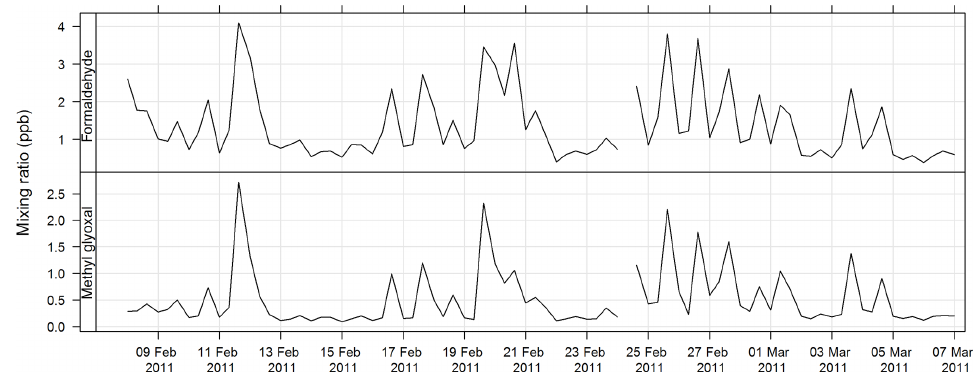
Figure 19. Time series of ambient formaldehyde and methylglyoxal mixing ratios during SPS-I.